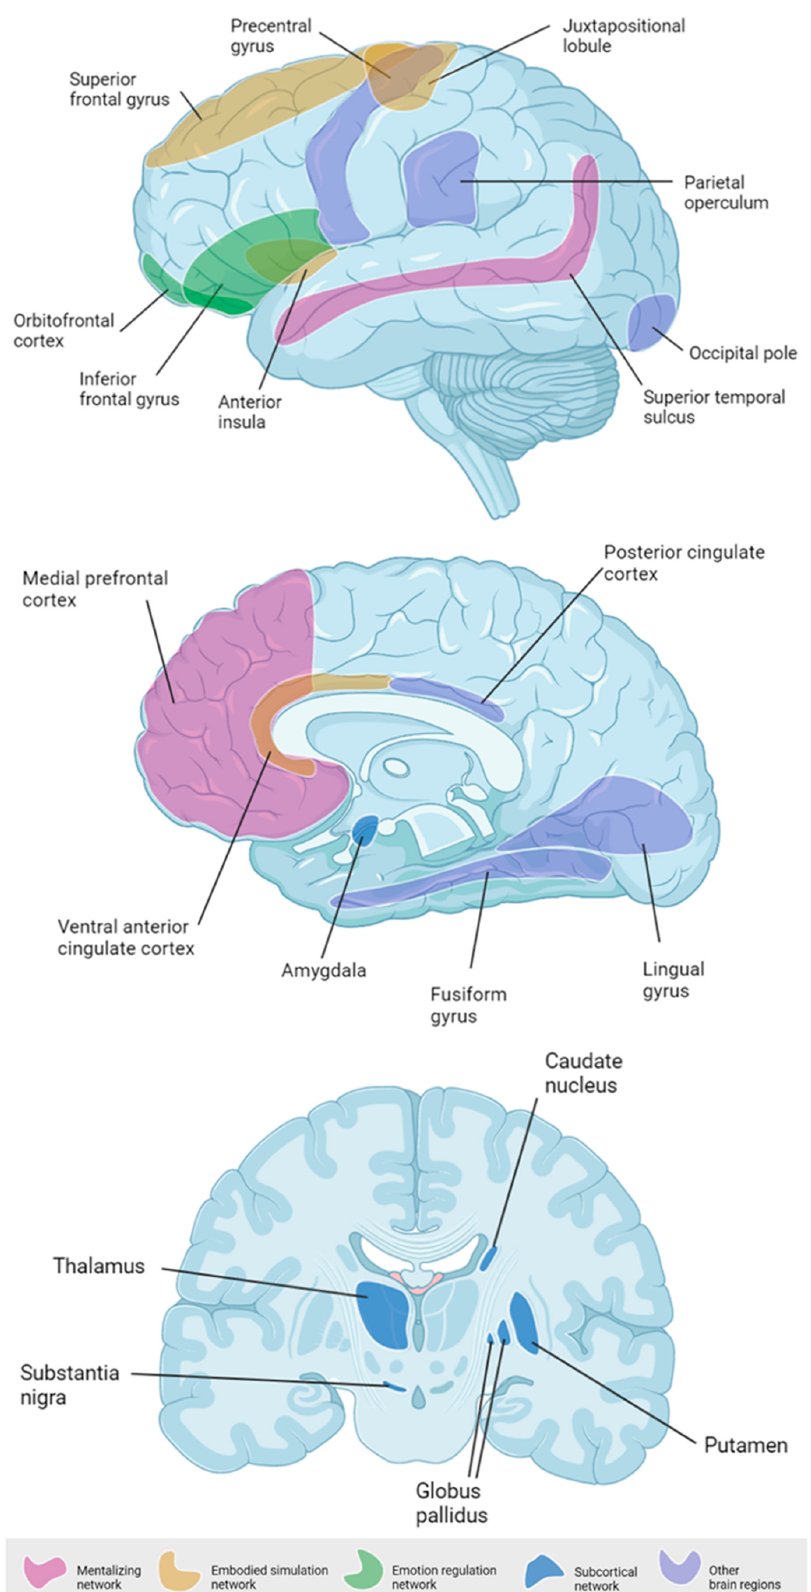
Figure 3. Schematic representation of brain regions activated by the exposure to child-related stimuli in fathers.